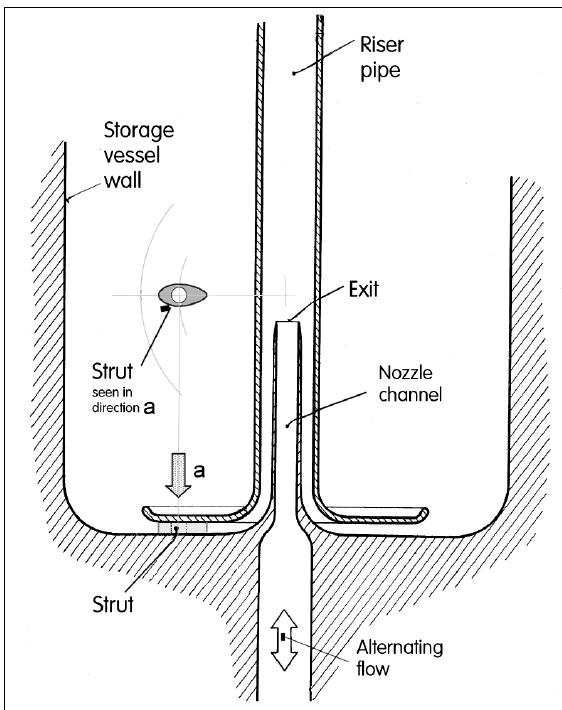
Figure 14. Another picture from [3] shows the rectifier used in an analogy to Figure 13 to stop the reaction in emergency situations. The liquid from the riser pipe is then kept in the storage vessel.